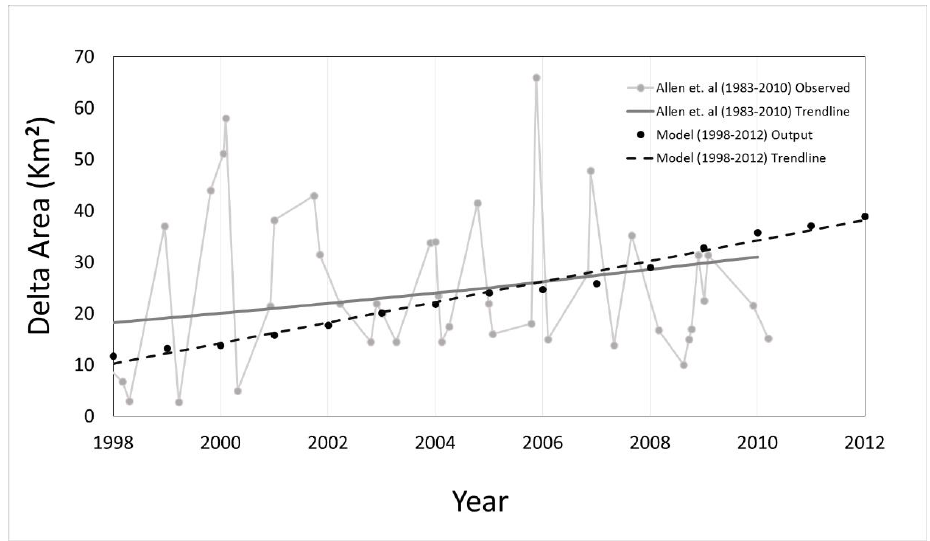
Figure 9. Land change trends for Wax Lake Delta (in km 2 ). The model predicted delta areas are represented by black circles and the delta growth trend line is represented by black dashed lines. Observed delta area is represented by grey circles and the trend line is represented by solid grey